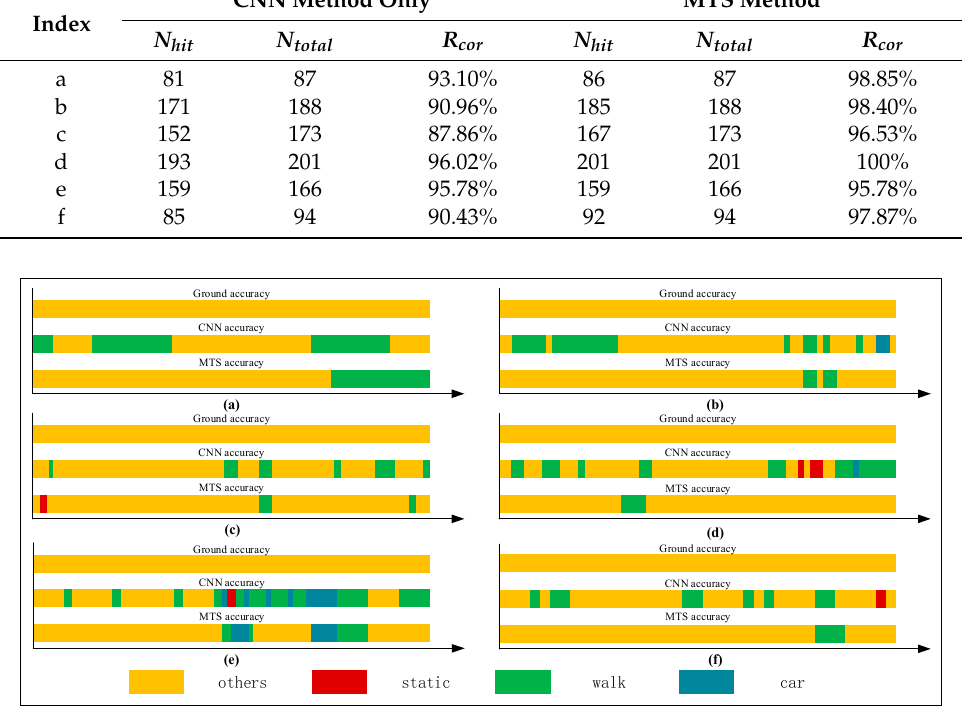
Figure 12. Graphs showing recognition of the other states.